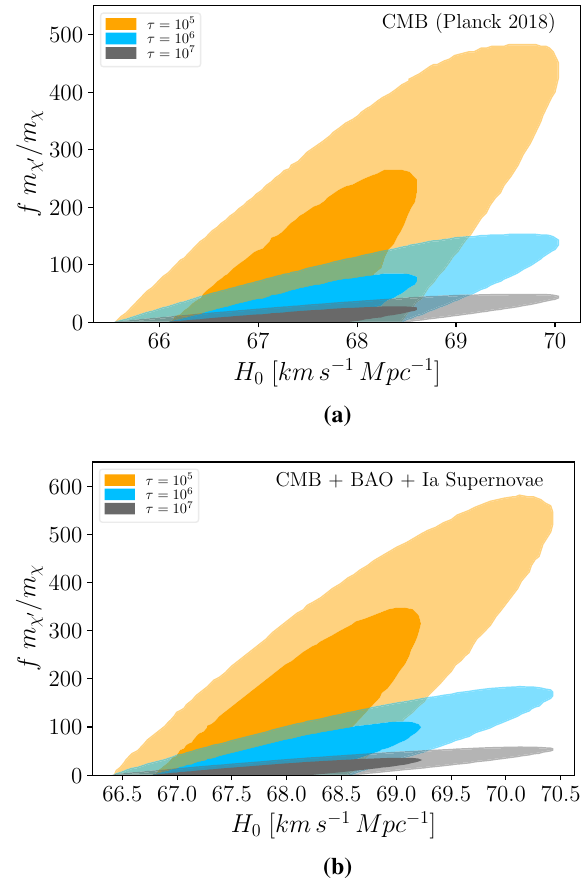
χ ν mechanism. → + / m χ and H 0 for different decay ′ 5 6 7 s, 10 s, or 10 s. The bigger contour corresponds to